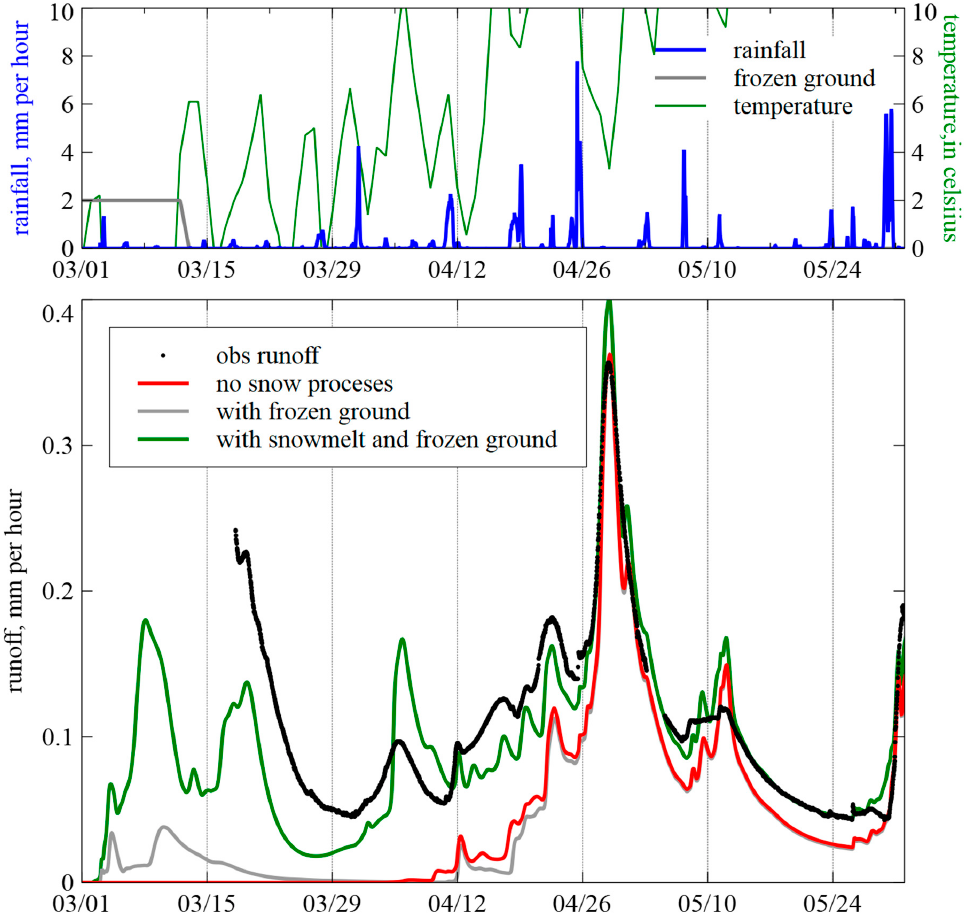
Figure 3. Model simulation in Cedar River at Cedar Rapids, from 1 March to 1 June 2008. The upper panel shows basin average rainfall and temperature. The gray line indicates when ground is frozen. The bottom panel shows streamflow simulations with and without snow